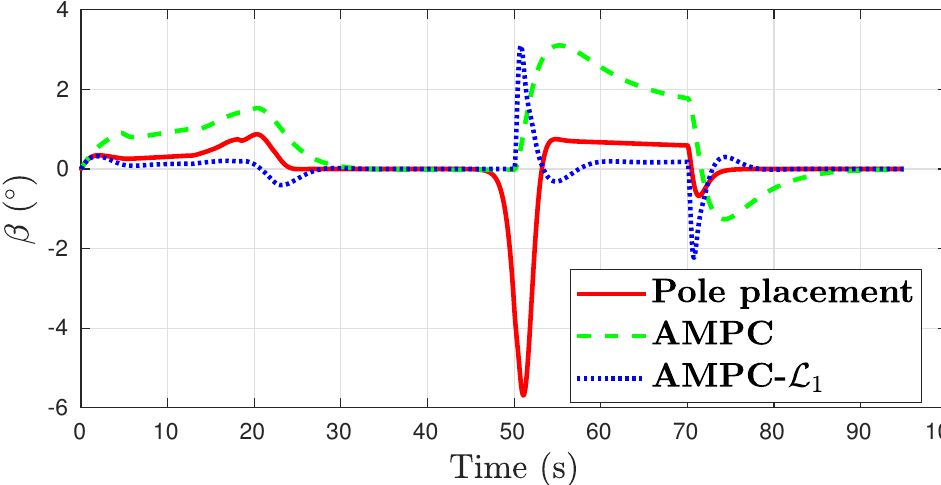
Figure 14. Sideslip regulation error for guidance uncertainty